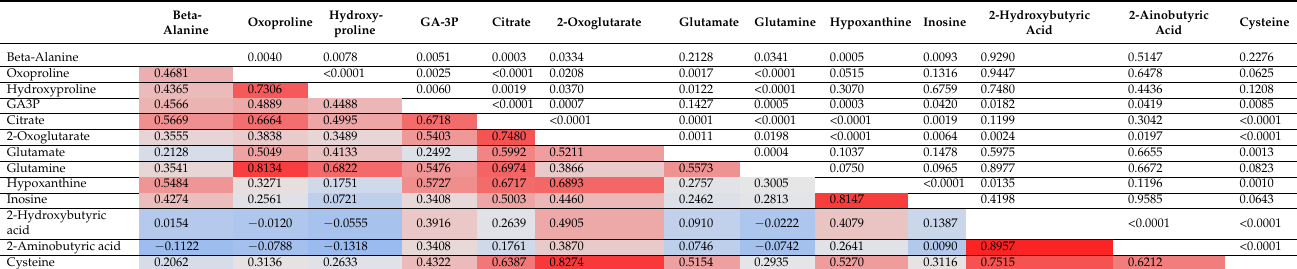
Table 3. Correlations of energy balance related metabolites and compounds connected to tissue protection. The upper right corner contains p -values for the correlation probability and the lower left corner the correlation coefficients (r). In addition, the correlation is visualized with a color gradient from r = − 1 (dark blue), gray intermediate to r = 1 (red). Beta- Hydroxy- Alanine Oxoproline proline GA-3P Citrate 2-Oxoglutarate Glutamate Glutamine Hypoxanthine Inosine